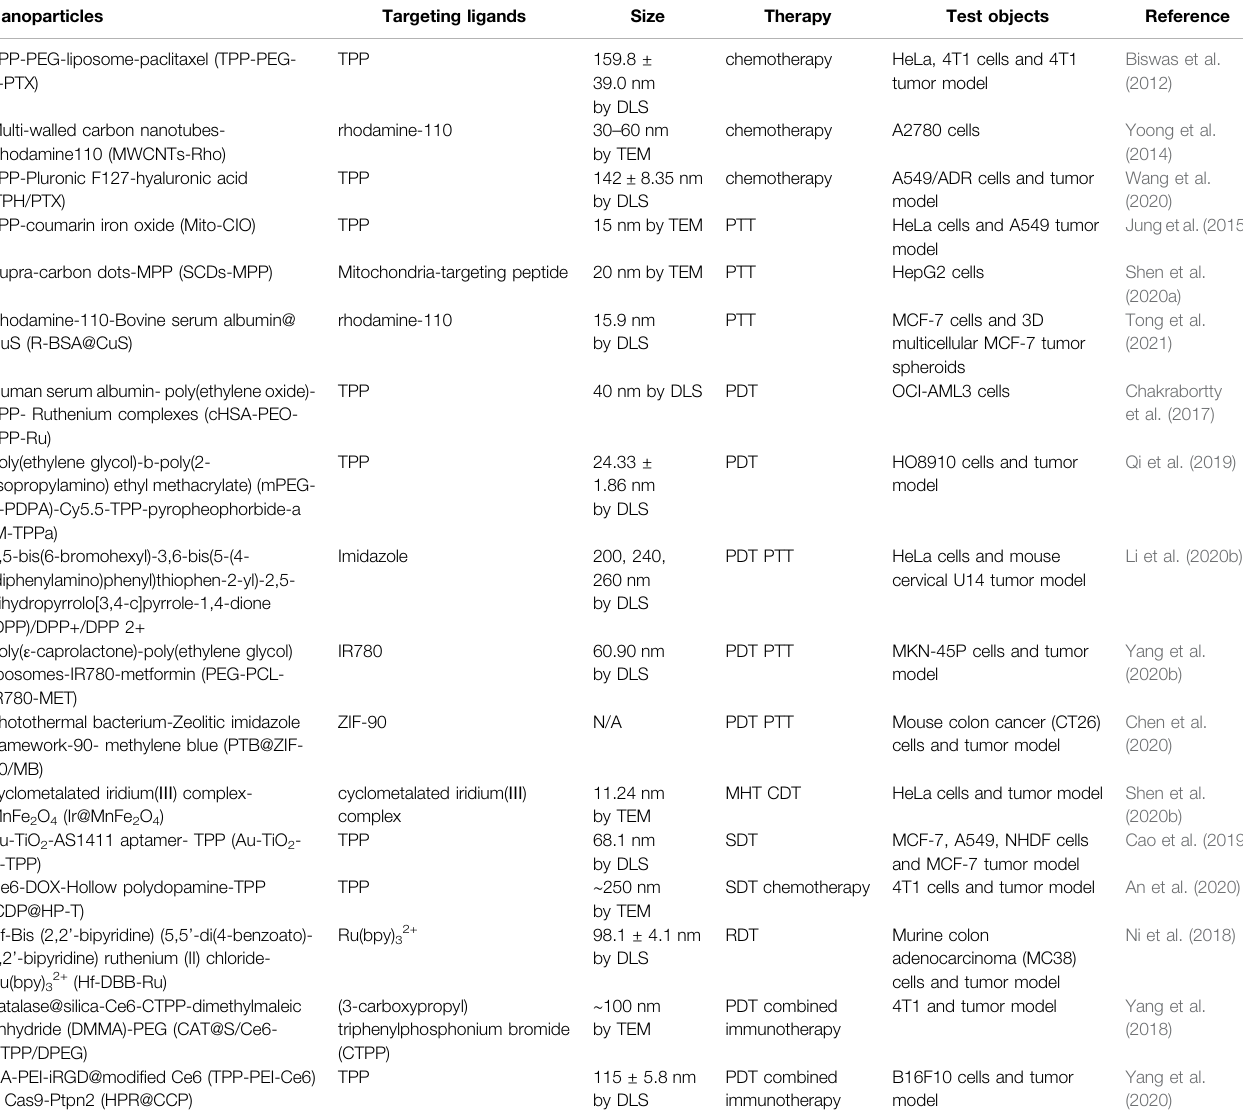
TABLE1| Asummarizationofmitochondria-targetedcancertherapiesinwhichnanoparticlesused,withtheirtargetingligandsandtumorcellsareusedtodemonstratetheir ef fi cacies.